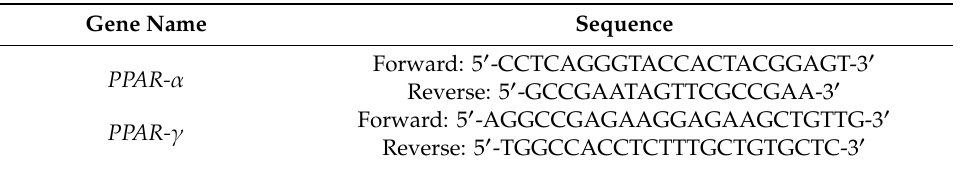
Table 2. Sequences of primers of peroxisome proliferator-activated receptor-alpha (PPAR- α